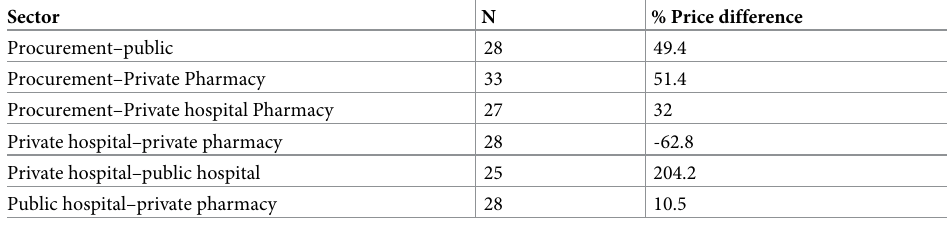
Table 4. The percentage price difference between lowest priced generics procurement and patient